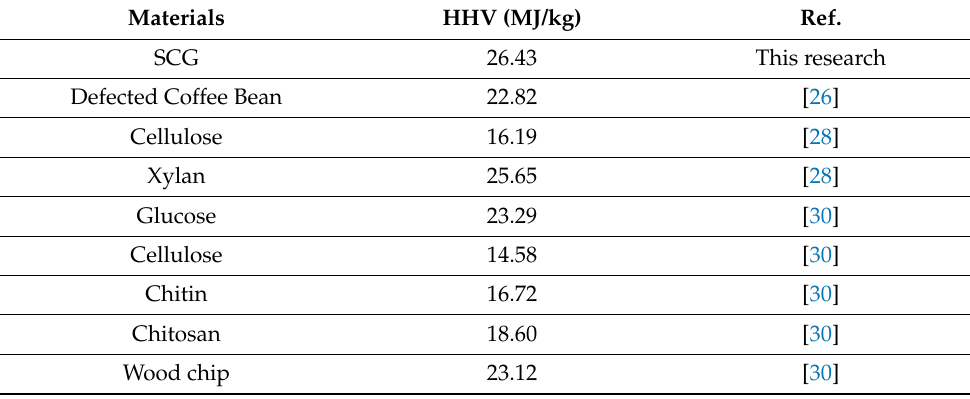
Table 5. HHV from HTC of different biomasses at 200 ◦